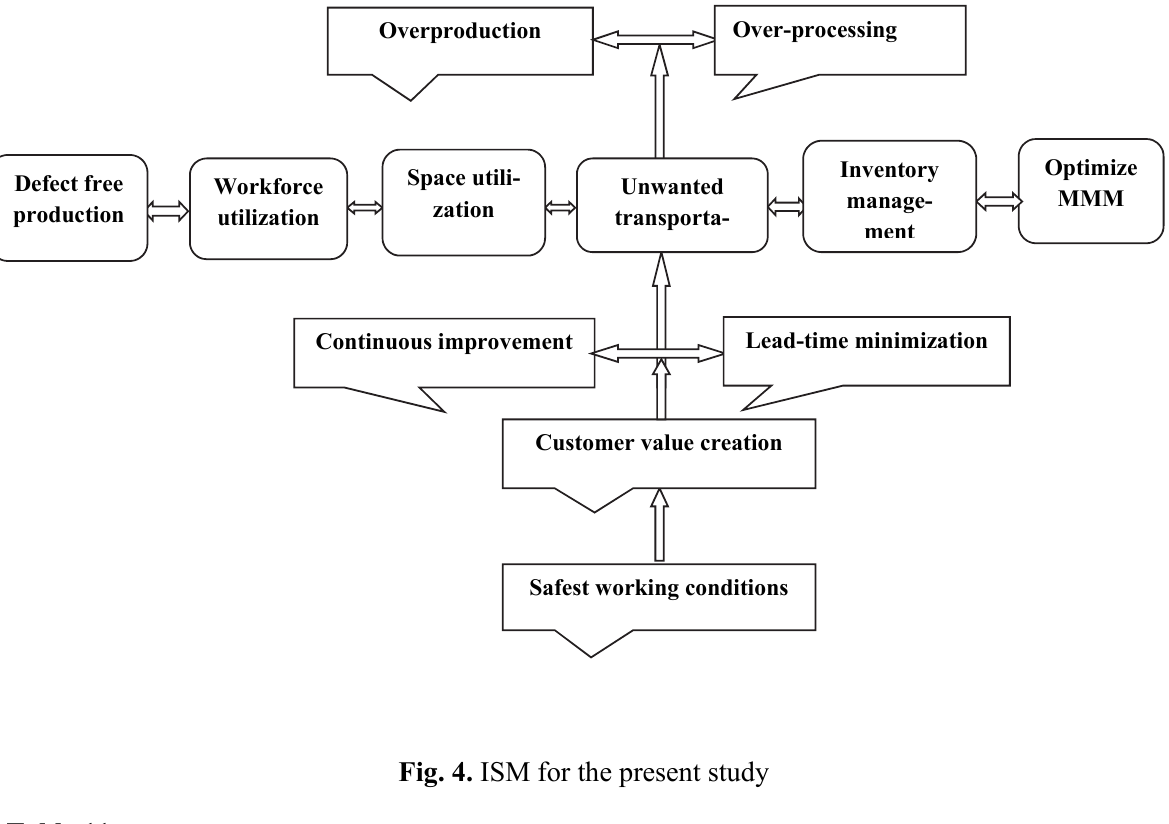
Fig. 4. ISM for the present study